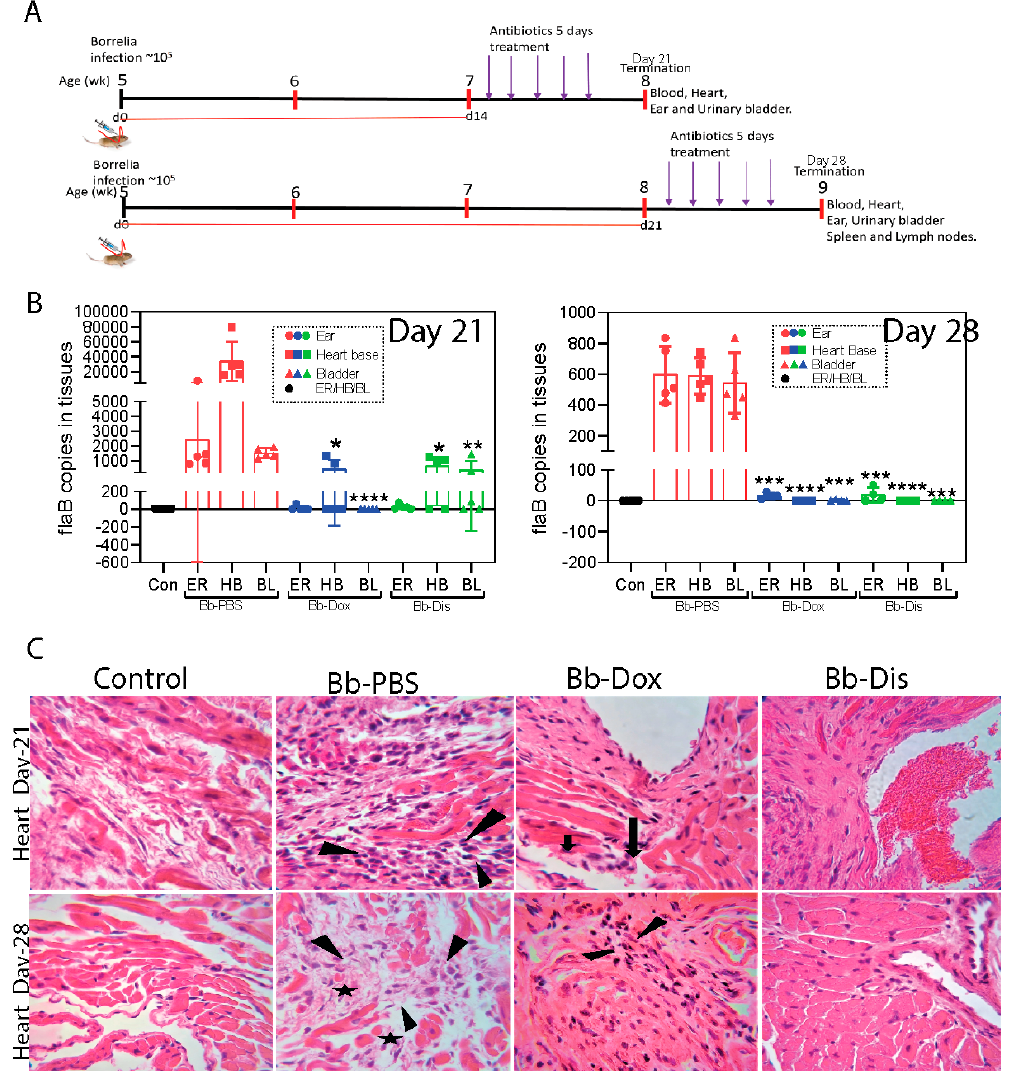
Figure 3. Borrelia loads in various tissues after C3H-HeN mice infection followed by disulfiram or doxycycline antibiotics treatment. ( A ) Antibiotic treatment/borrelia infection schedule: groups of 5 weeks old C3H mice ( n = 30) were infected subcutaneously above the shoulders with mid log-phase 10 5 B. burgdorferi. Infected groups were received intraperitoneal antibiotics doxycycline ( n = 5), disulfiram ( n = 5) and PBS ( n = 5) at two different time points: day-14 post infection and day-21 post infection. Uninfected groups of mice were kept as controls ( n = 10). ( B ) Necropsy at the end of day-21 and day-28, ears, hearts and urinary bladders were collected for determination of the number of Borrelia flab per ul of sample by qPCR. ( C ) Photomicrographs (40×) of hematoxylin and eosin-stained heart sections; arrows depict the mono nuclear leucocyte infiltrates. Statistics by unpaired t-test with Welch’s correction between drug-treated group versus infected group. * p < 0.05, ** p < 0.01, *** p < 0.001, **** p <0.0001. Table 1. In vivo efficacy of drugs against B. burgdorferi in C3H/HeN mice. No. of